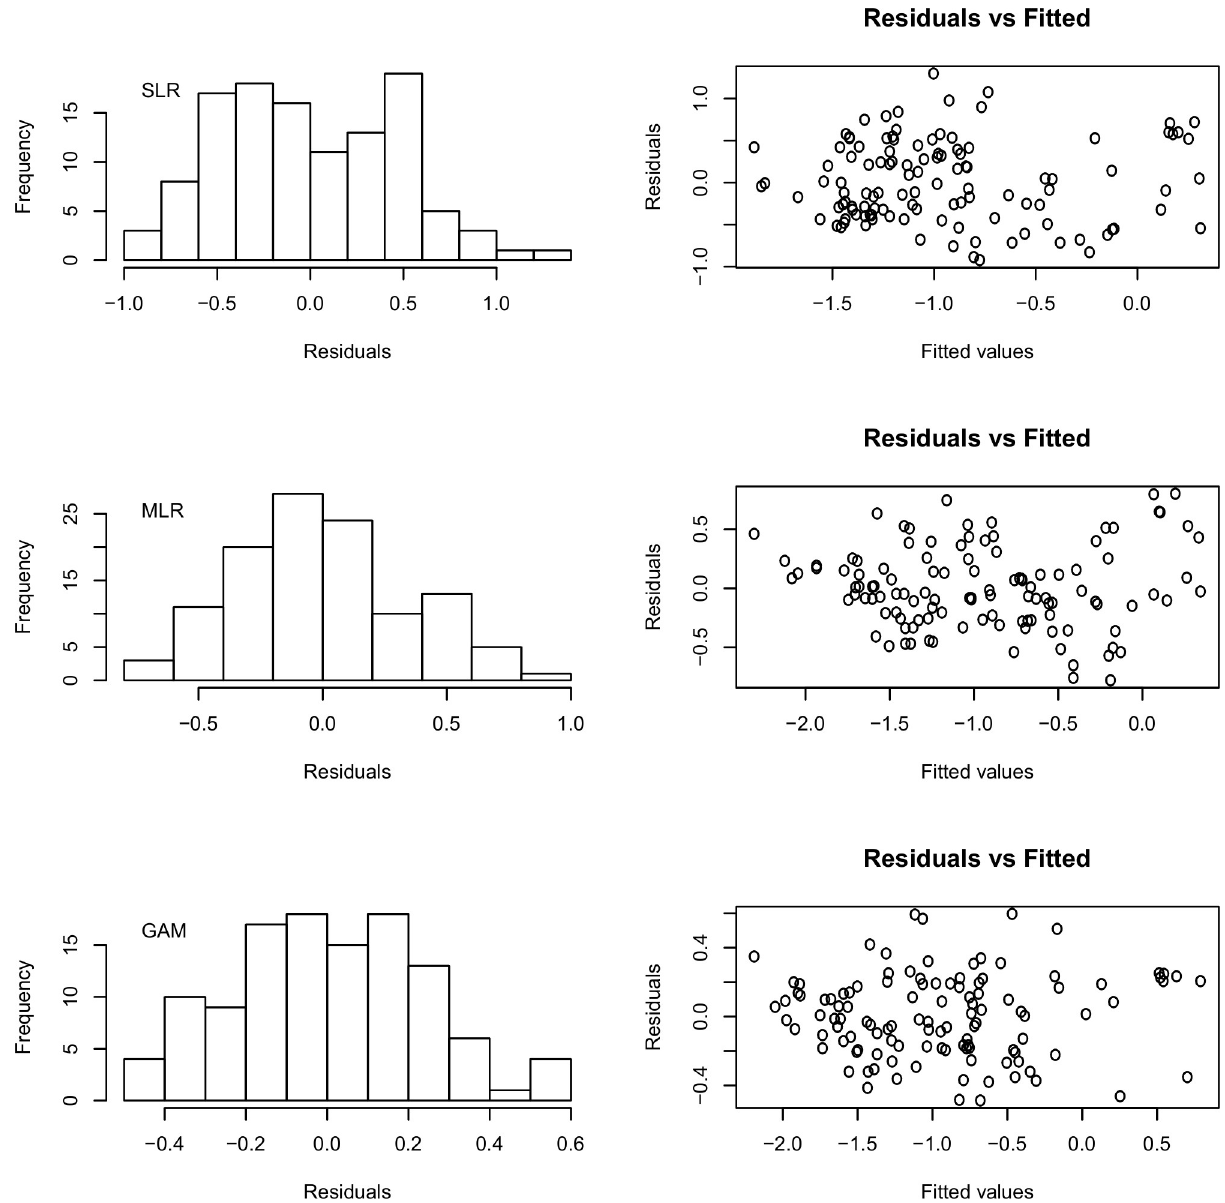
Fig 3. Residual analysis of the best fitted SLR (top), MLR (center), and GAM (bottom), respectively.